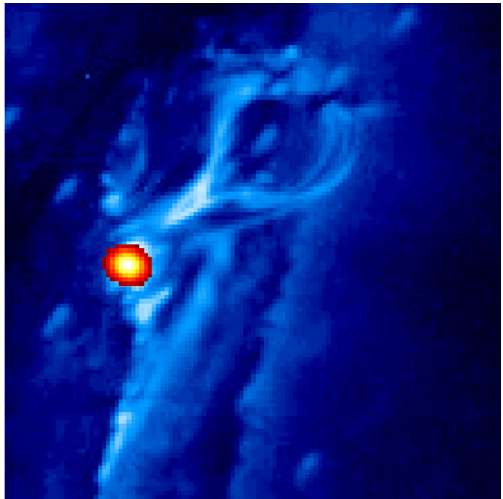
Fig. 26 Still from a movie: An overview in Fe xii EUV emission observed by EIT/SOHO, later zooming into the observations by TRACE, both showing thermal coronal emission of a plasma at about 1.5 MK. The 12–25 keV hard X-ray emission observed by RHESSI is shown in red and yellow colors . Image courtesy of Pascal